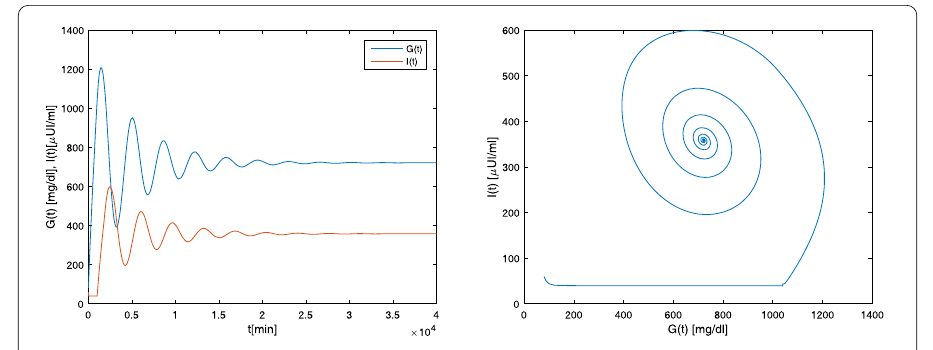
Figure 3 Time series and phase portrait of fractional-order model (29) generated using the information from Set 2, the parameter values in Eq. (58), and τ = 1000 < τ 0 = 1365.60. The positive equilibrium ( G ∗ , I ∗ ) = (722.65,359.07) of the system is asymptotically stable